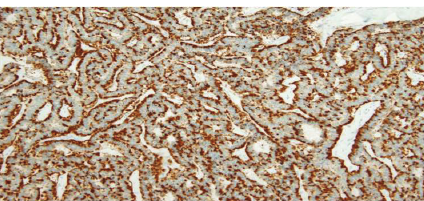
Figure4:ChromograninA-stainedsection.Tumorcellsarepositive for chromogranin A immunostain (magnification: × 200).